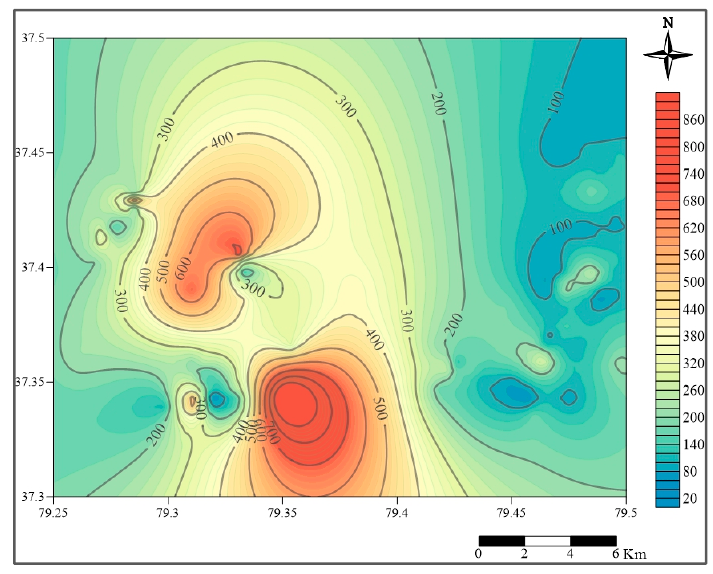
Figure 9. Spatial distribution of water quality index (WQI).